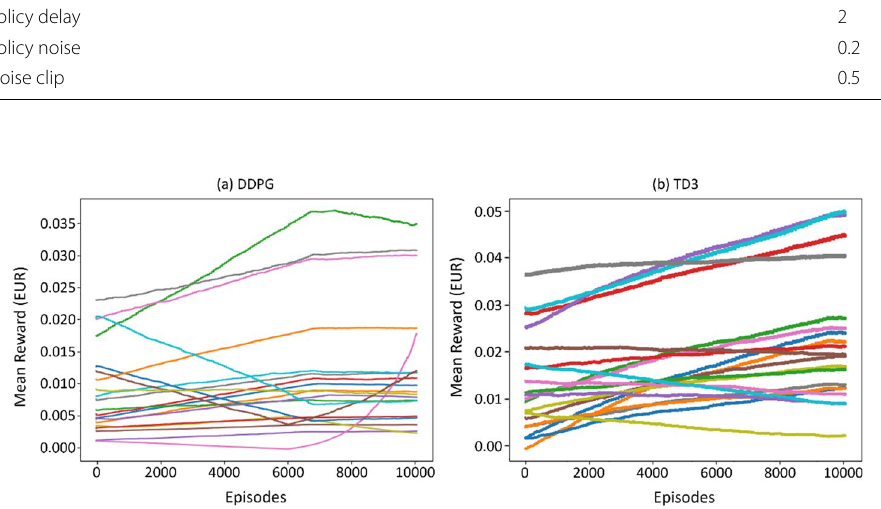
Fig. 7 Mean reward for each agent per training episode: ( a ) DDPG, and ( b )